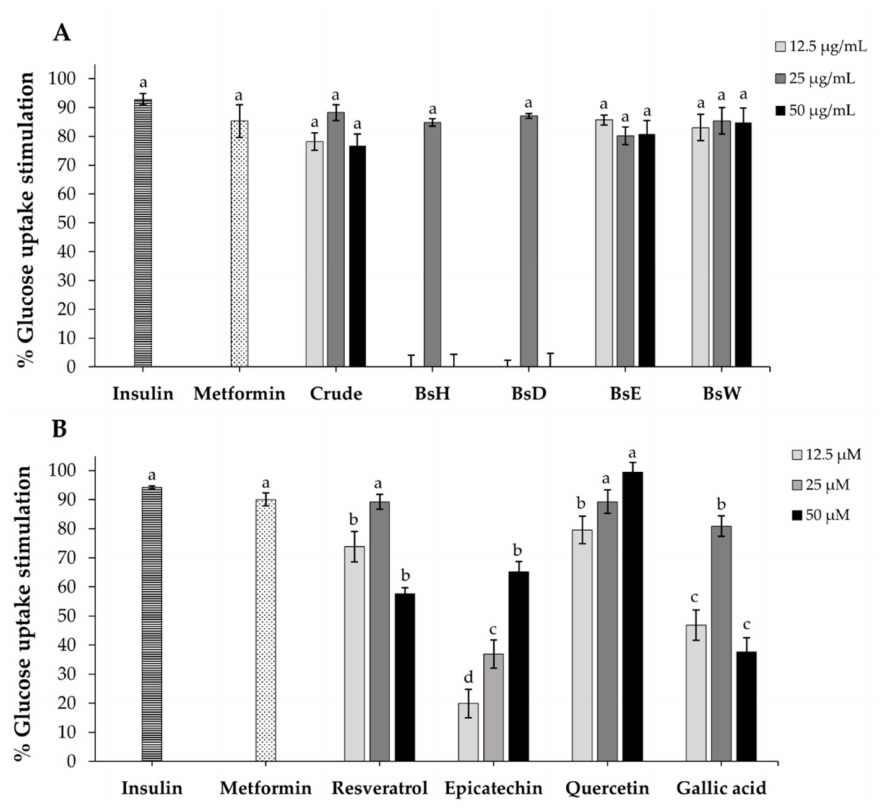
Figure 4. The percentage of glucose uptake stimulation in 3T3-L1 adipocytes after treatment with various concentrations of crude extract ( A ), partitioned fractions ( A ), and isolated compounds ( B ). Insulin (100 nM) and metformin (2 mM) were used as the positive control. Results are expressed as mean ± SD ( n = 3). Different letters significantly indicate difference ( p <